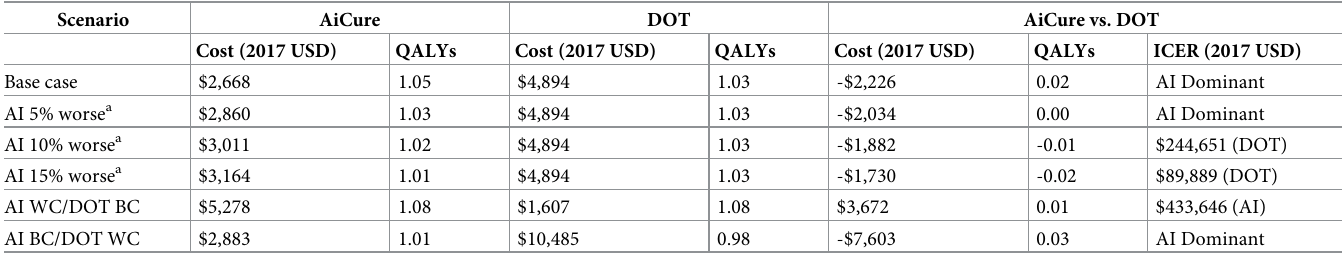
Table 4. Model results under base case and scenario analyses.